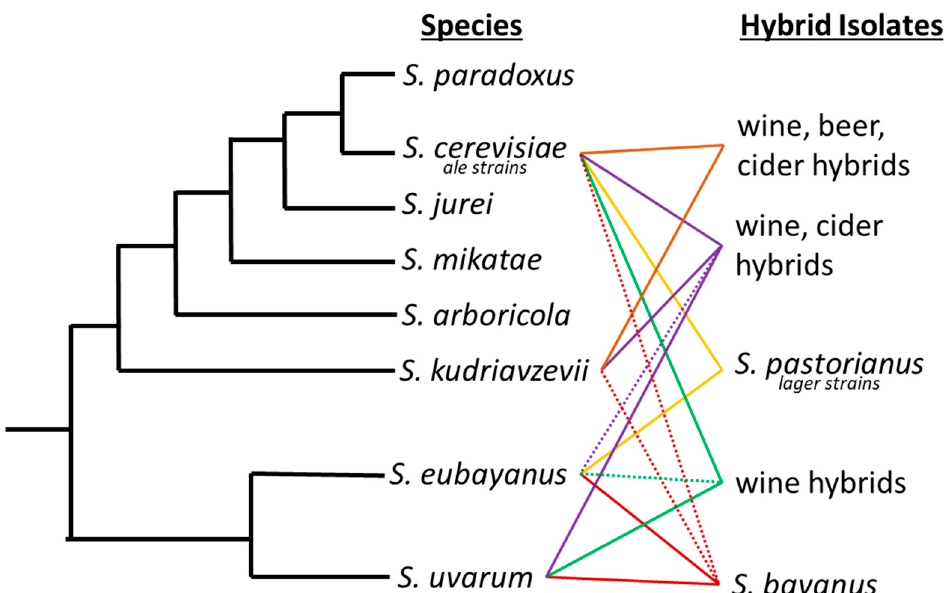
Figure 1. Saccharomyces phylogenetic tree with industrially important hybrids. Industrial hybrids are listed to the right by the fermentation they have predominately been associated with. Solid lines between two species signifies the interspecific hybrids and dashed lines denote introgression from a third or fourth species that may not always be present in each hybrid